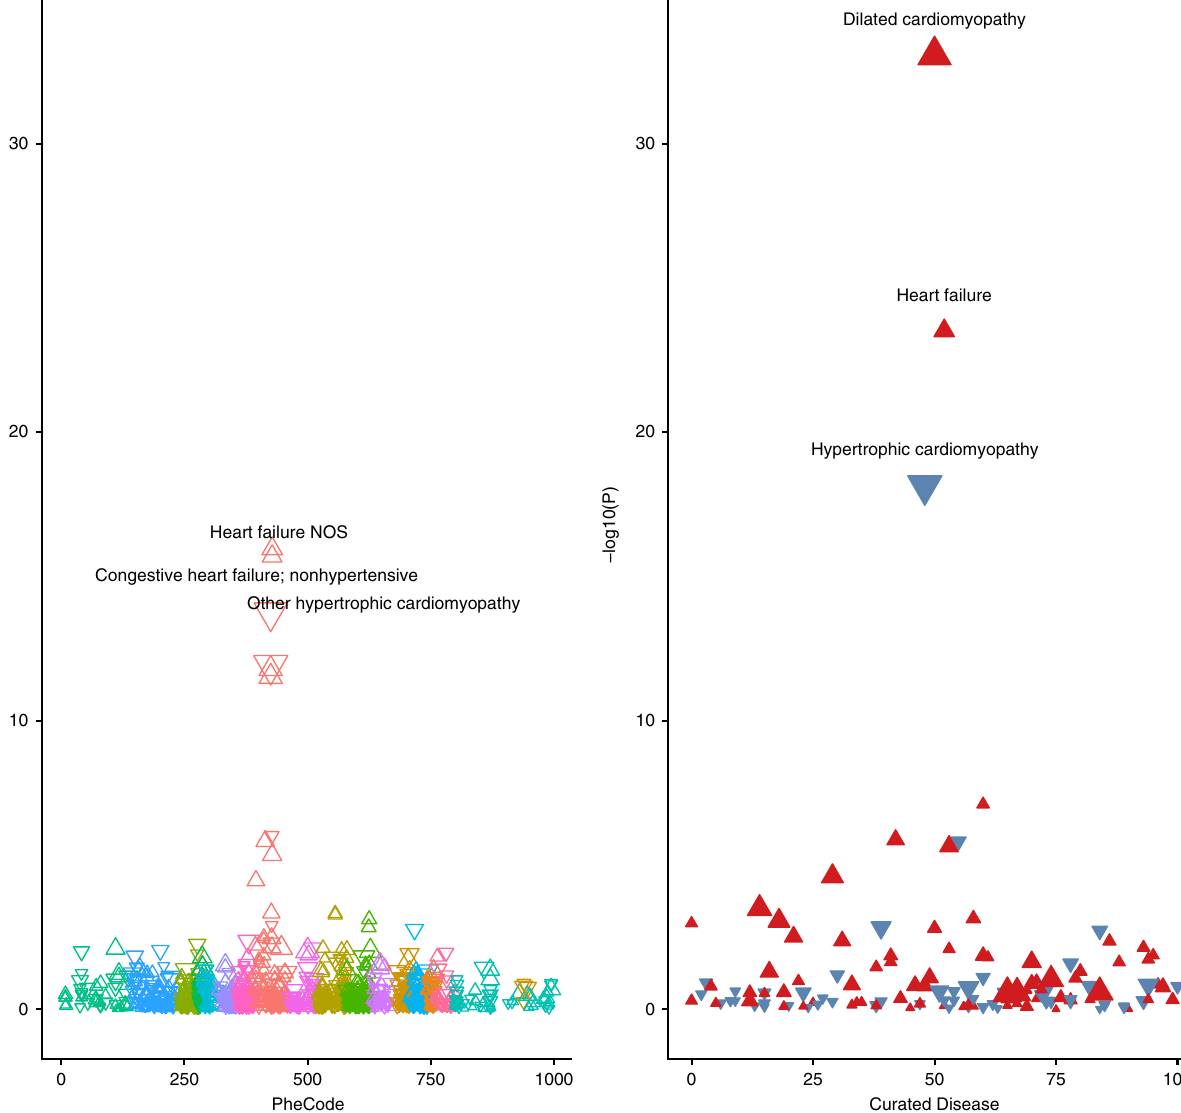
Fig. 2 PheWAS highlights the connection between a polygenic score for LVESVi and dilated cardiomyopathy. The polygenic score derived from LVESVi was applied to PheCodes (panel a ) and curated disease phenotypes (panel b ) in the UK Biobank. Each of the curated phenotypes is de fi ned in Supplementary Table 1. For both panels ( a ) and ( b ), the x -axis represents the identifying code for the disease phenotype. The y -axis represents the − log10 of the P value of the association between the polygenic score and the phenotype in a logistic model adjusted for age at enrollment, the genotyping array, sex, and the fi rst fi ve principal components of ancestry. Triangles oriented upward represent betas that are concordant with the LVESVi PRS (e.g., a higher LVESVi PRS corresponds with a higher risk of DCM), and the reverse is true for downward-oriented triangles. The three most strongly associated phenotypes in each panel are labeled in the fi gure. The triangles in panel (a) are colored by three-digit PheCode. The triangles in panel ( b ) are colored red if positively correlated with the LVESVi polygenic score, and blue if negatively correlated. The PheWAS plots for all seven cardiac MRI phenotypes are available in Supplementary Fig.